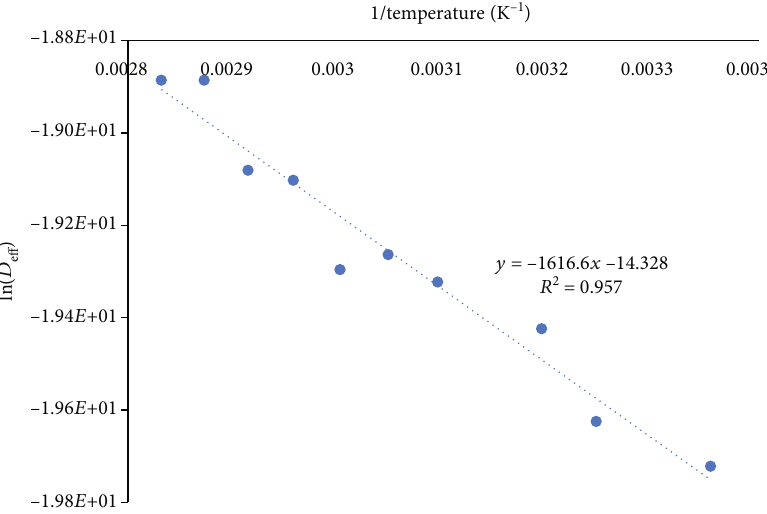
Figure 8: Arrhenius plot for the di ff usion of potassium in potato spheres preheated at 80 °